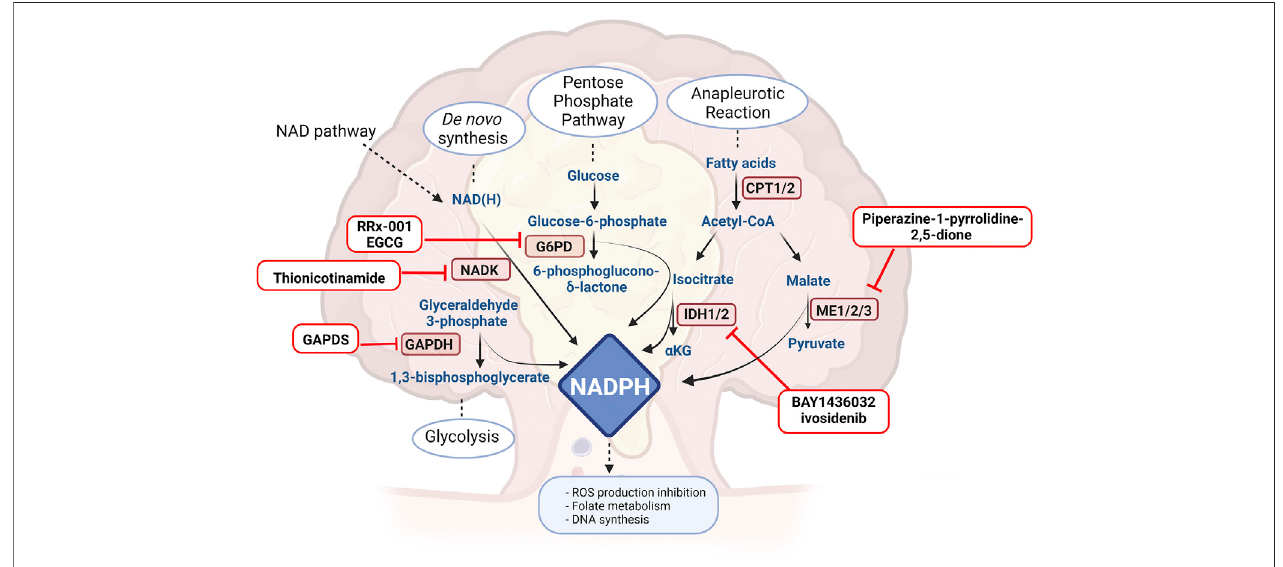
FIGURE2| DrugsormoleculesthathavebeenpostulatedaseffectiveinCRCandthattargetNADPHroutes.G6PH:glucose6-phosphatedehydrogenase,NADK: NAD kinase, CPT: carnitine palmitoyl transferase, ME: malic enzyme, IDH: isocitrate dehydrogenase, GAPDH: glyceraldehyde 3-phosphate dehydrogenase. Created with